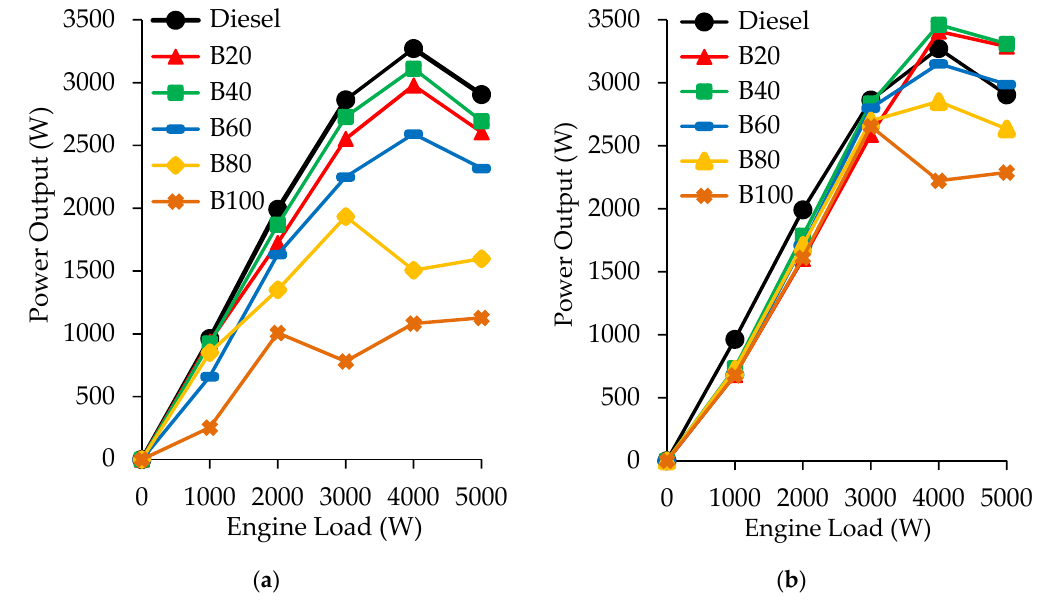
Figure 4. Power output (W) at different engine loads (1000–5000 W) for ( a ) diesel/ethyl acetate/sunflower oil; ( b ) diesel/ethyl acetate/castor oil blends. The error in measurements was always less than 3%.